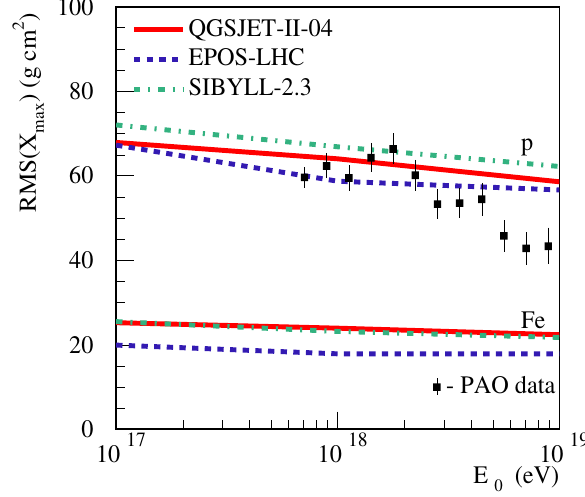
Figure 7. Primary energy dependence of RMS( X max ) for proton- and iron-initiated vertical EAS, as calculated using the QGSJET- II-04, EPOS-LHC, and SIBYLL-2.3 models (solid, dashed, and dashed-dotted lines respectively), compared to PAO data [23]